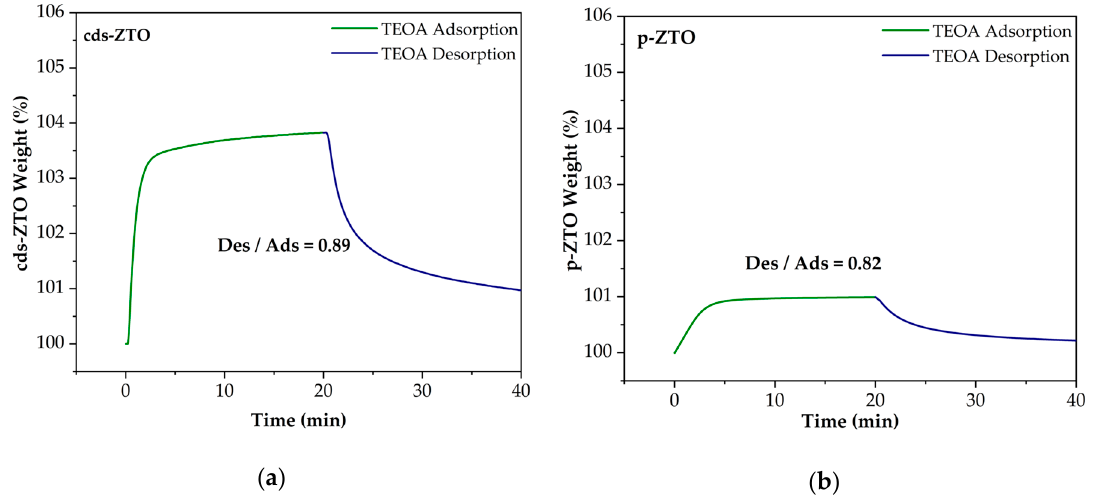
Figure 10. Adsorption–desorption isotherms of TEOA on ( a ) cds-ZTO, ( b ) p-ZTO.